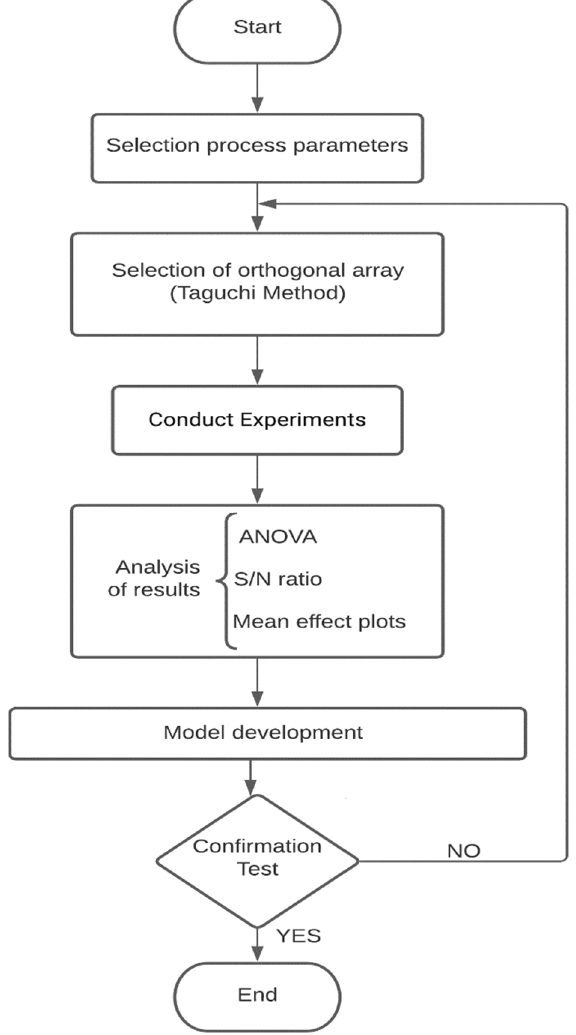
Figure 3. Flowchart of implementing the steps. Table 2. L9 orthogonal